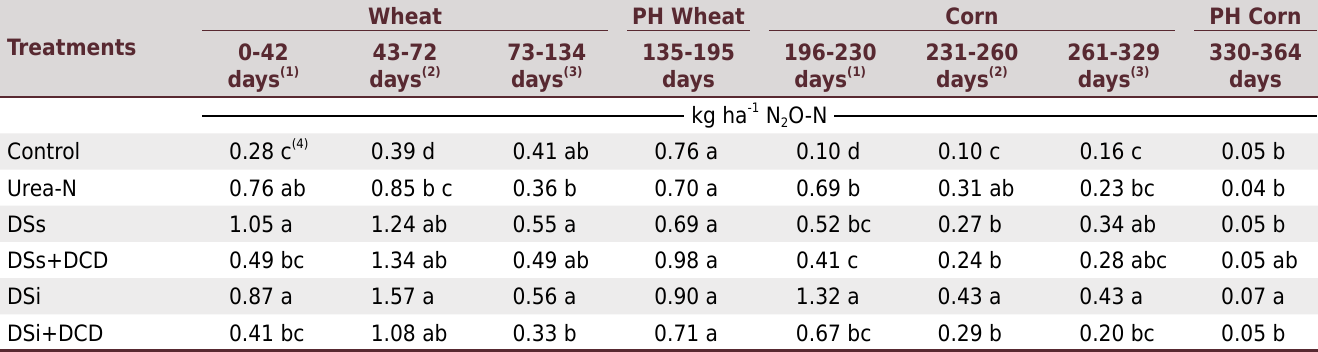
Table 2. Emissions of N 2 O during wheat and corn growing seasons and post-harvest (PH) Treatments